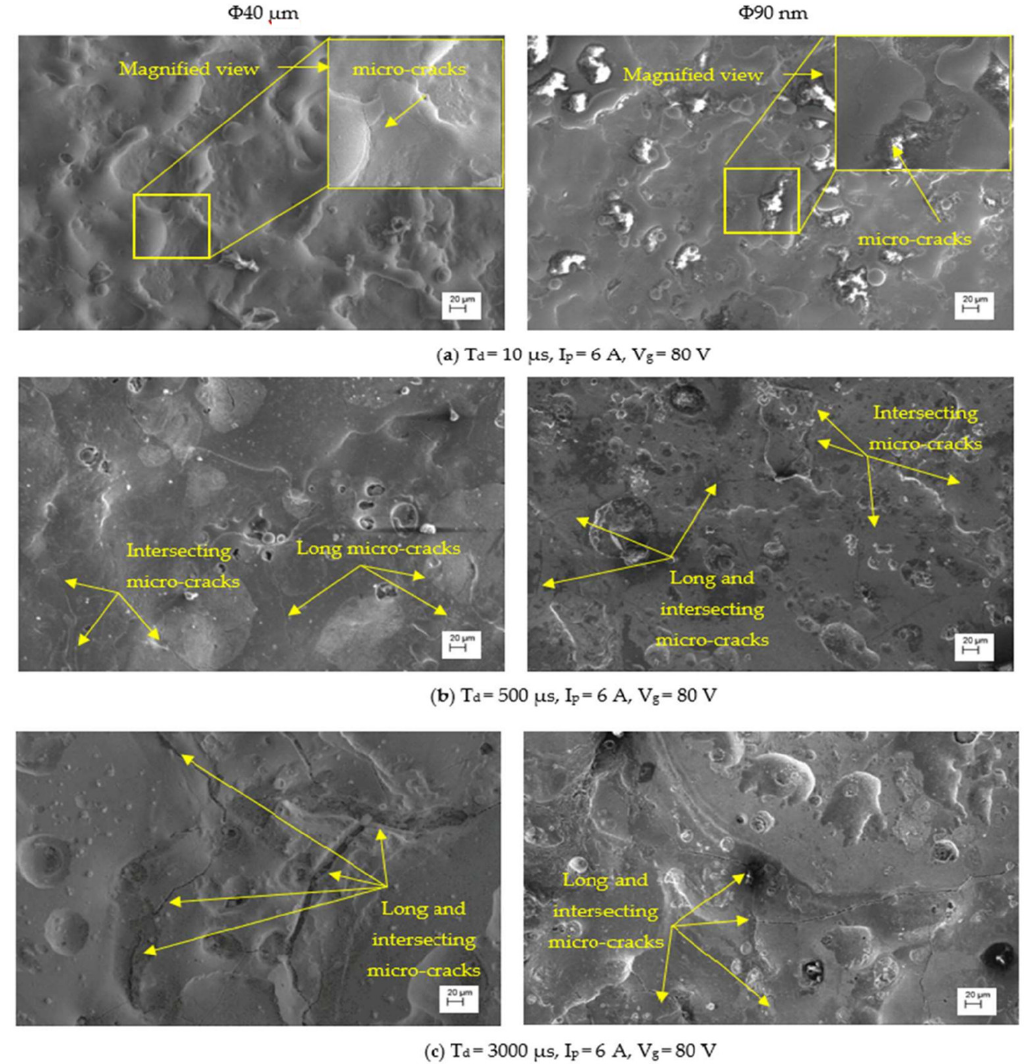
Figure 15. SEM micrographs with various discharge durations.